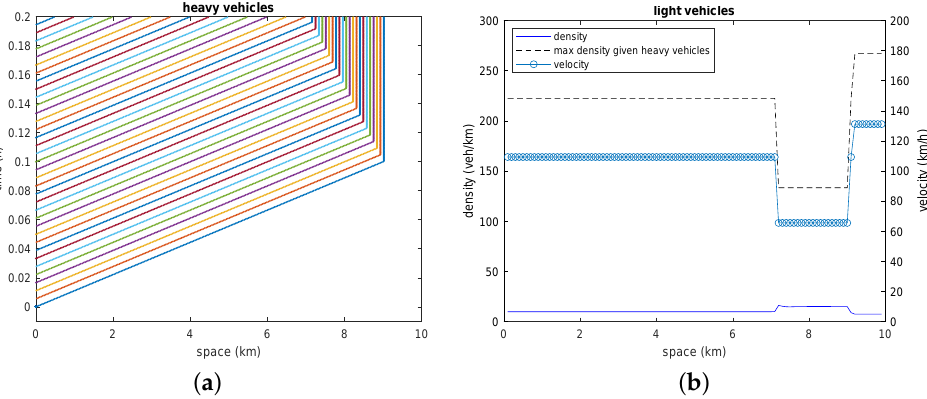
Figure 15. Test 1B: ( a ) Trajectories of trucks in space–time (for visualization purposes, not all trucks are actually plotted). When the first truck stops, a queue is formed behind. ( b ) Car density, car velocity and car maximal density given the number of trucks at final time. Creeping is visible between 7 and 9